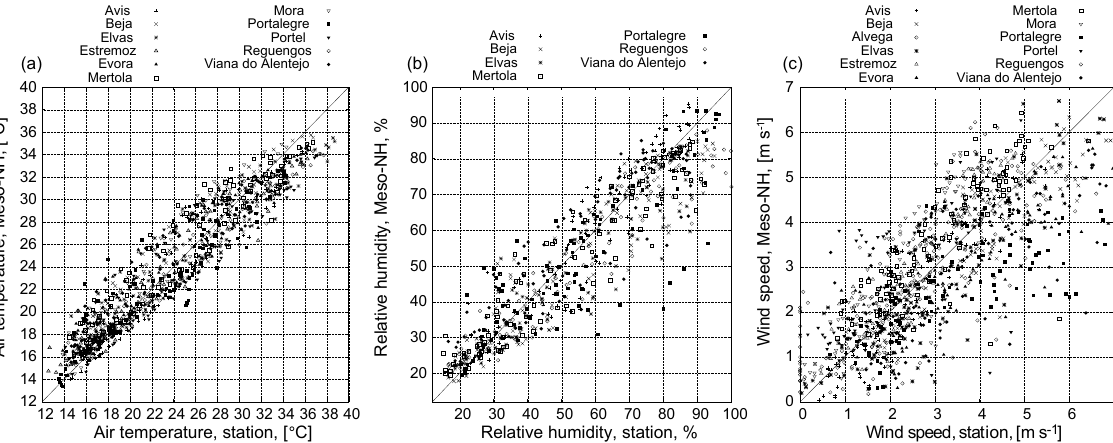
Figure 5. Scatter plots of the comparison between Meso-NH simulation LAKE1 and measured values at synoptic stations. Air tempera- ture (a) , relative humidity (b) , and horizontal wind speed (c)